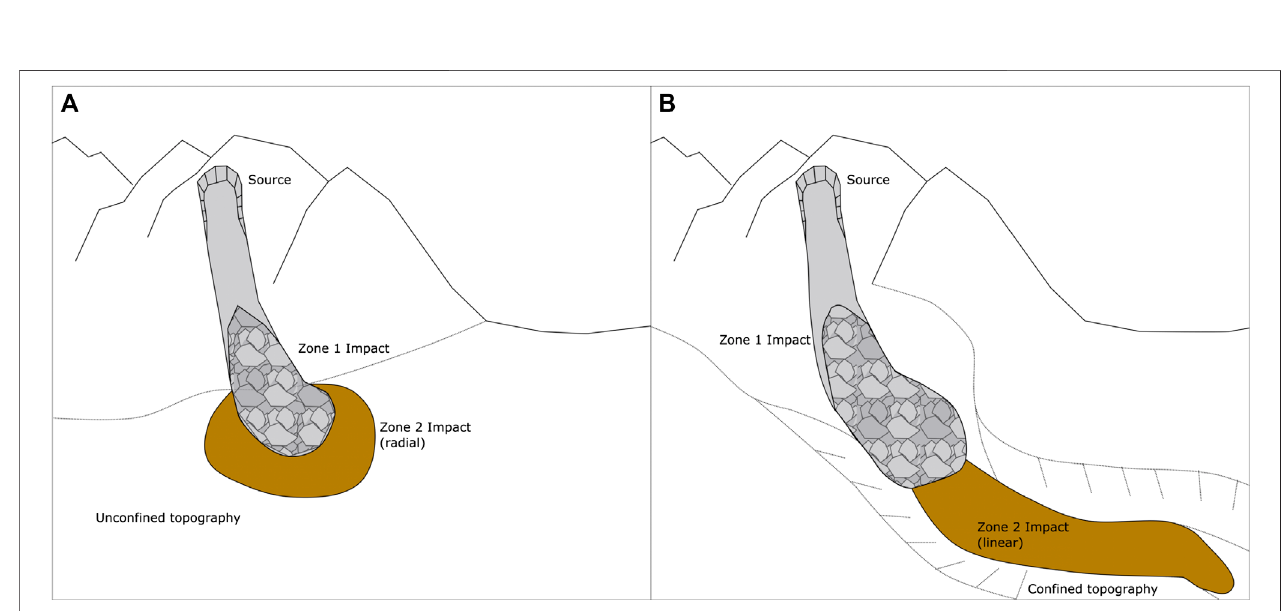
FIGURE 4 | De fi nition sketch showing (A) a radial Zone 2 impact zone, and (B) a linear Zone 2 impact zone.